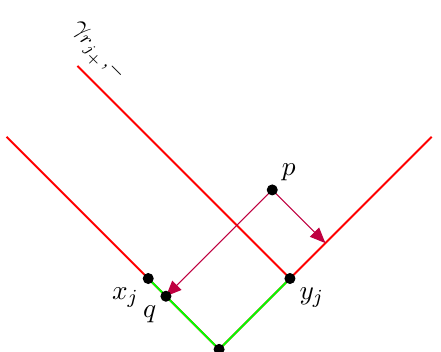
Figure 5. Illustration for lemma 7. The positively oriented past moving light ray from p meets σ j at q . If it crosses γ , then the negatively oriented past moving light ray from p meets γ r j , − + the future of y , contradicting p ∈ D ( σ ) j j